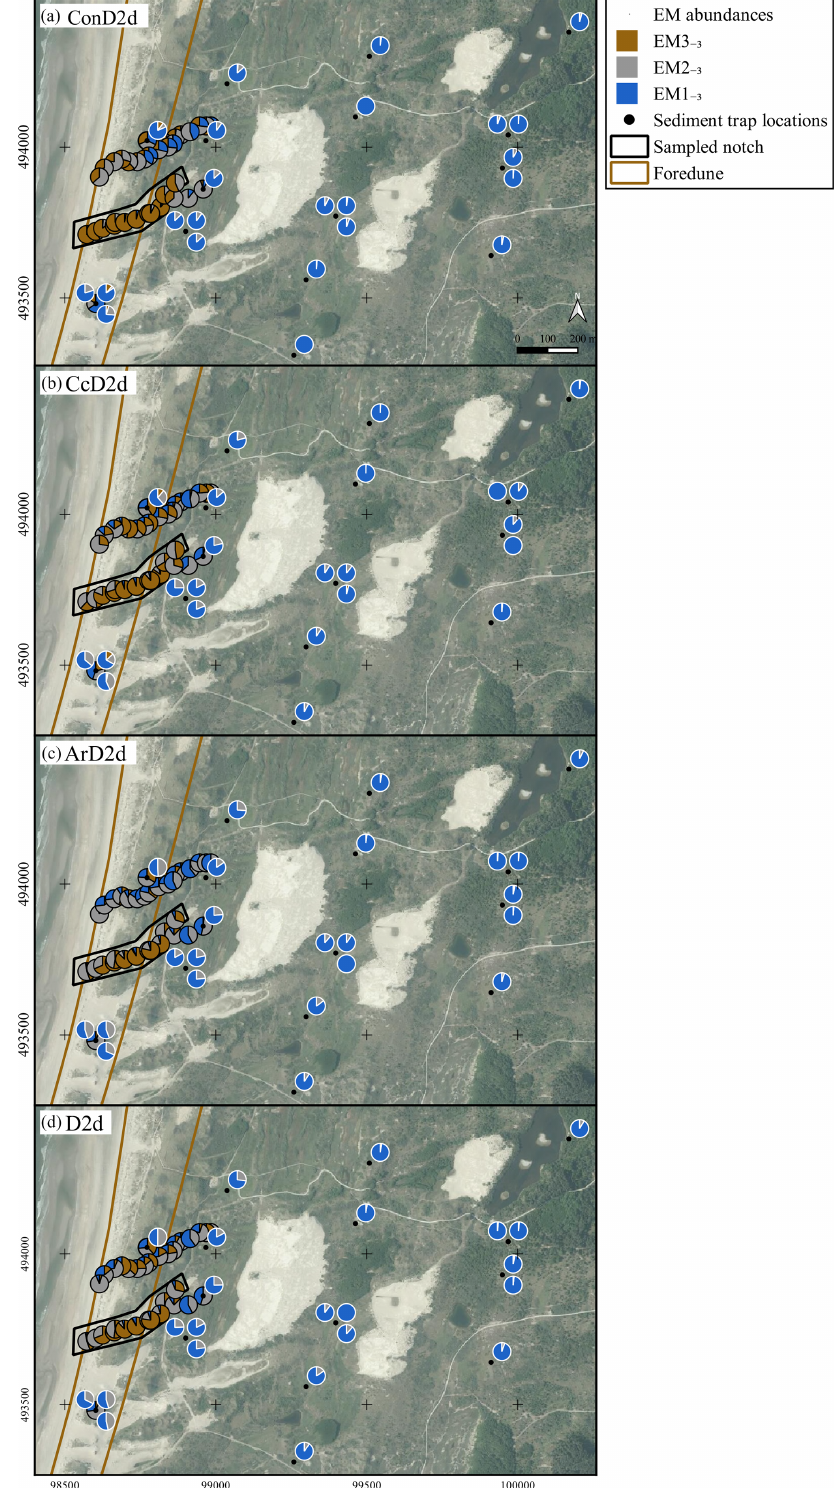
Figure A14. Pie charts showing abundances of the 3EM solution determined for the ConD2d (a) , CcD2d (b) , ArD2d (c) , and D2d (d) distributions of the dune dataset. Pie charts with a black outline denote surface samples and are plotted at the sampling location. Pie charts with a white outline denote sediment-trap samples and are plotted near the sampling location. The exact location of sediment traps is marked by black dots. Two of the subregions defined in Fig. 1c are shown in simplified form. Aerial photograph © PDOK.nl,